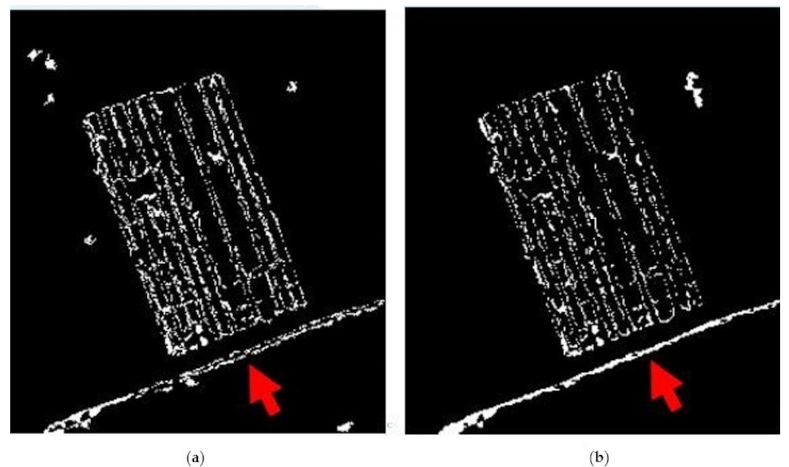
Figure 22. Wrongly classified pixels in the final change map. ( a ) Error pixels for Gabor-PCANet. ( b ) Errors for our proposed method.